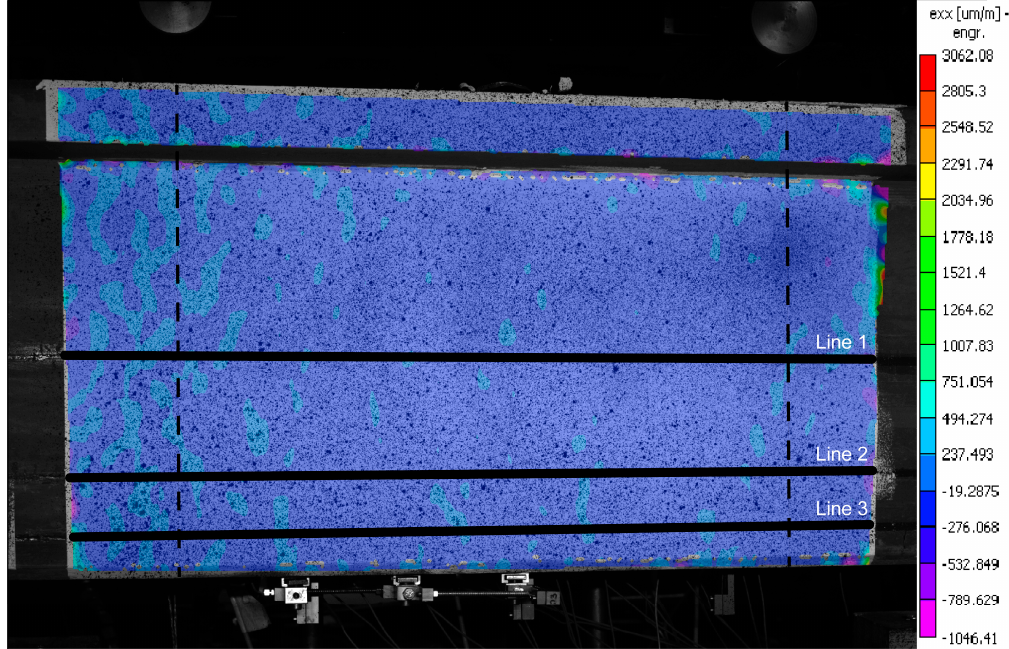
Figure 8. DIC measurement at unloaded state with virtual measurement lines noted; the constant bending moment zone is marked with dashed lines.